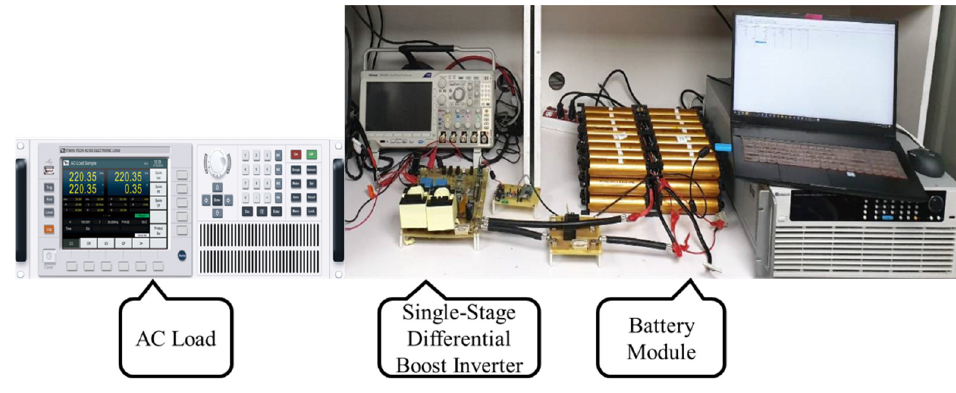
Figure 12. The laboratory setup of the test platform. Table 2. Specification of the proposed BESS.